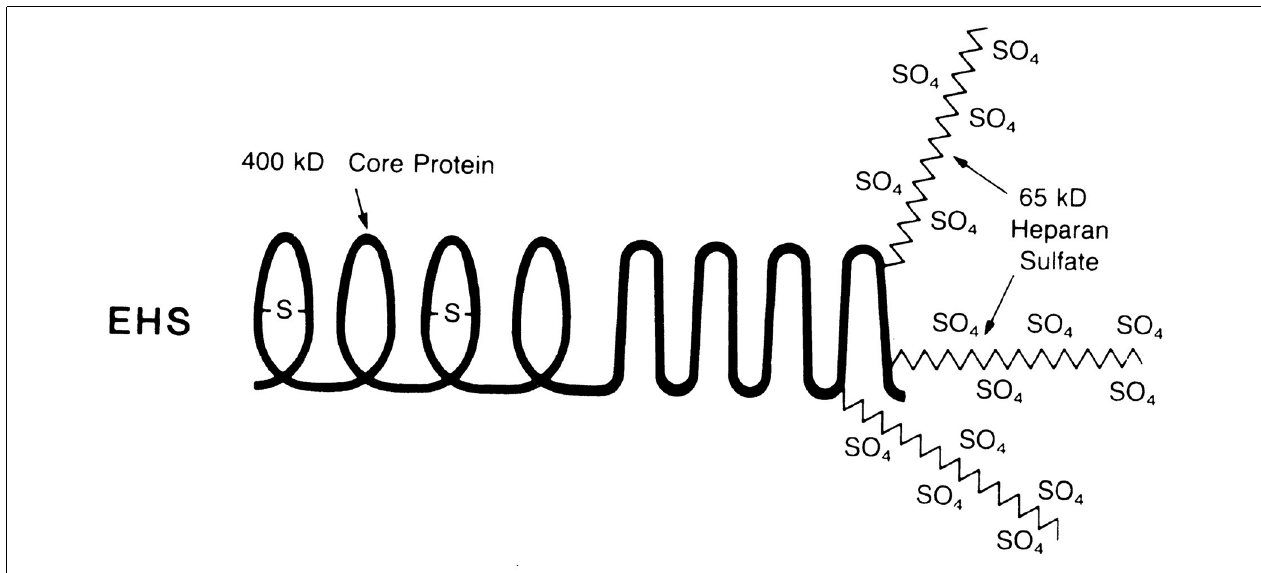
FIGURE 2 | Structure of the heparan sulfate proteoglycan perlecan derived from the Engelbreth-Holm-Swarm (EHS) sarcoma. The perlecan proteoglycan has a core protein of 400,000 MW containing three heparan sulfate chains of 65,000 MW each (Snow and Wight, 1989).